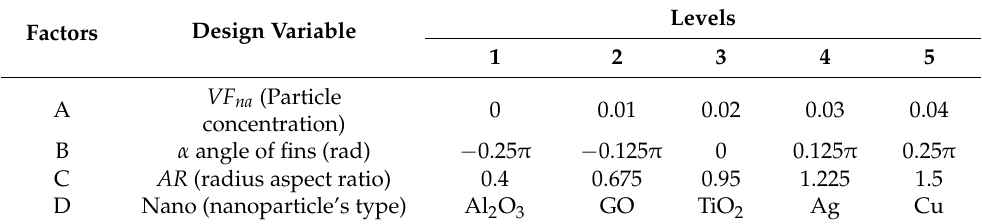
Table 4. The range and levels of control